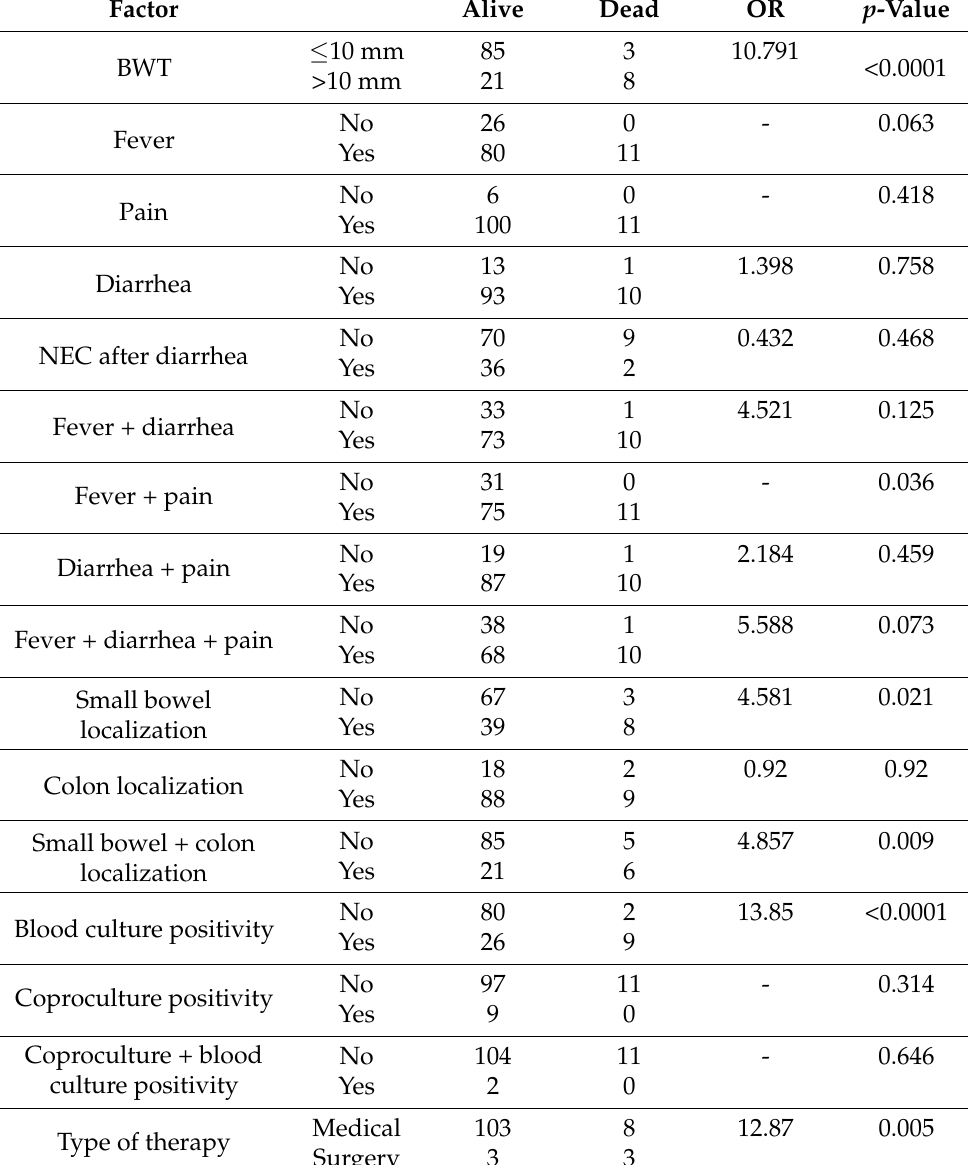
Table 2. Univariate analysis of the impact of clinical factors and BWT on outcome in n = 117 episodes of NEC. The results of multivariate analysis are reported in the